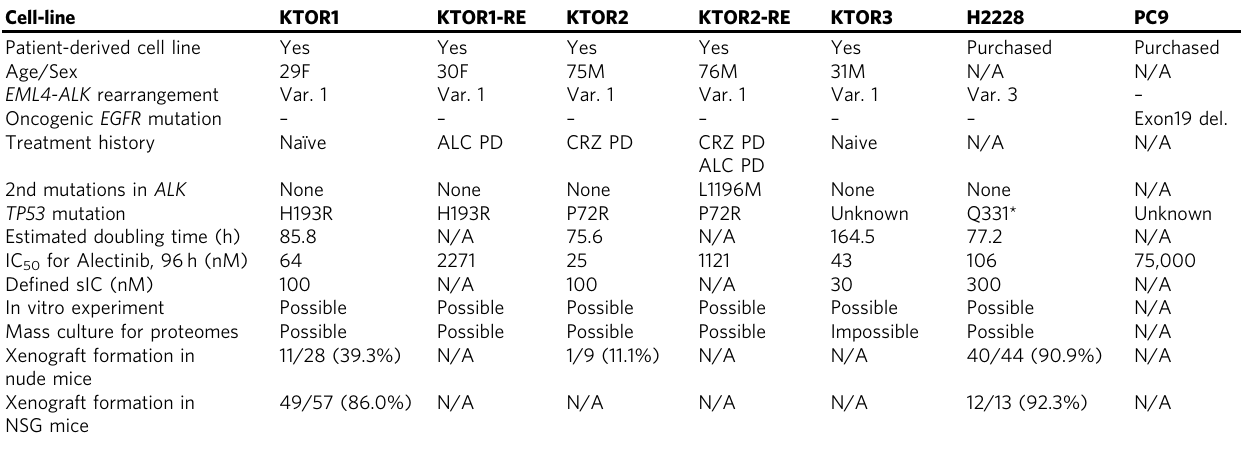
Table 1 Characteristics of patient-derived ALK-rearranged lung cancer